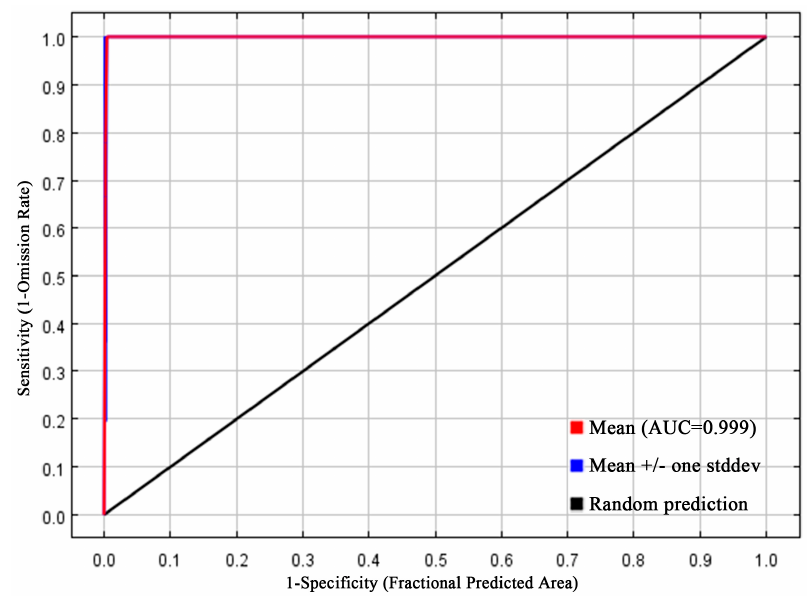
Figure 2. Prediction validation with receiver operator characteristic (ROC) curves using the MaxEnt model.